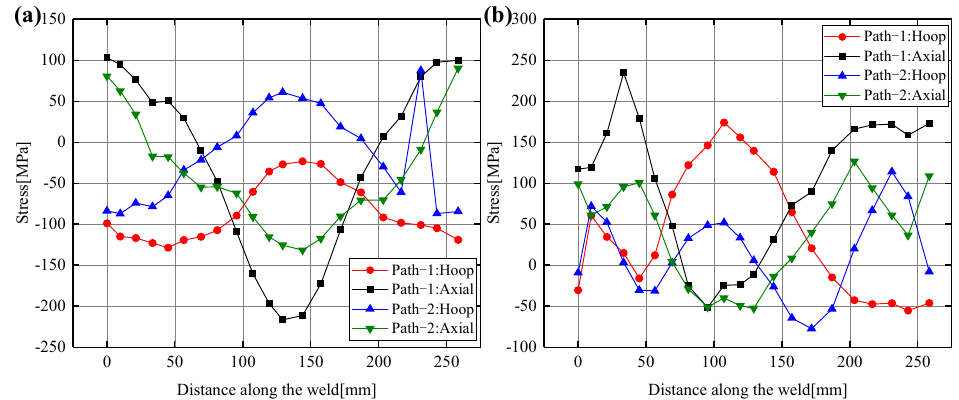
Figure 16. Hoop and axial residual stress distribution along the weld direction for Case3 and Case6 in the 0°–180° weld path: ( a ) Outer surface residual stress, ( b ) Inner surface residual